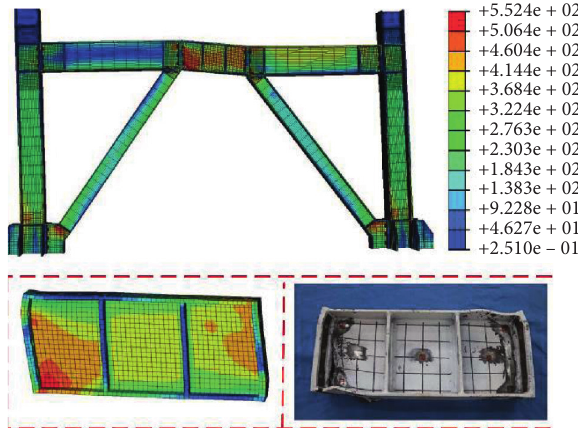
Figure 3: Simulated stress propagation in an eccentric bracing frame and its laboratory sample